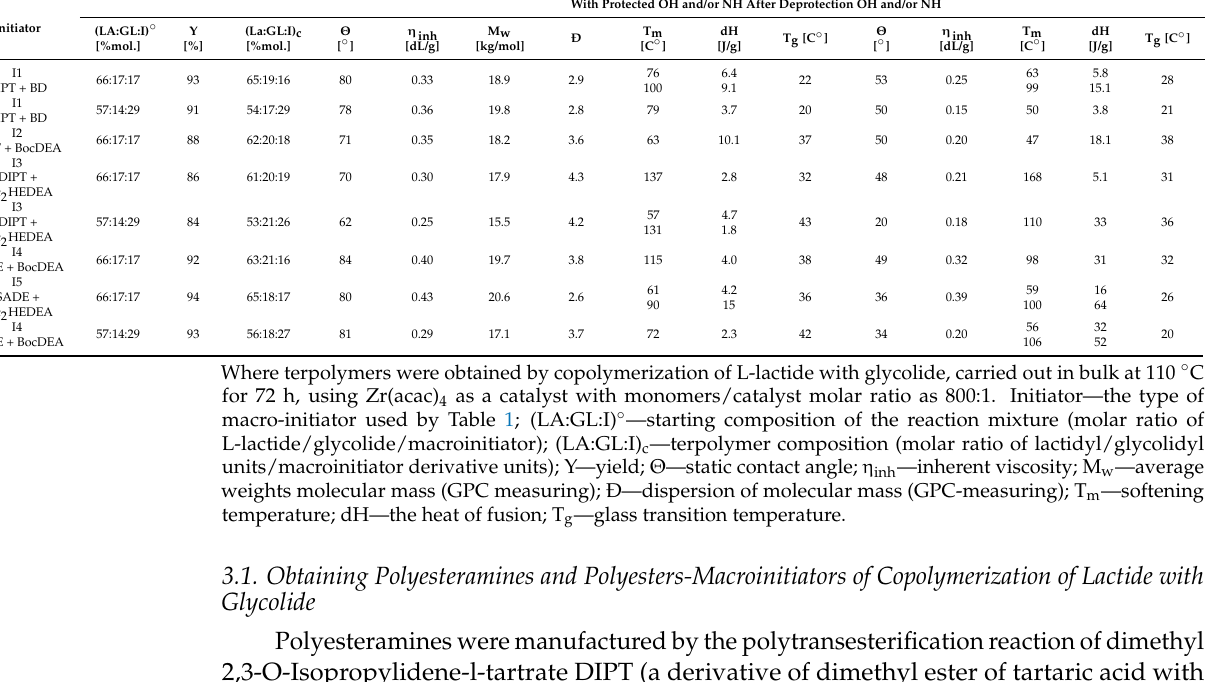
Table 2. Properties of terpolymers before and after deprotection of hydroxyl and amino groups.